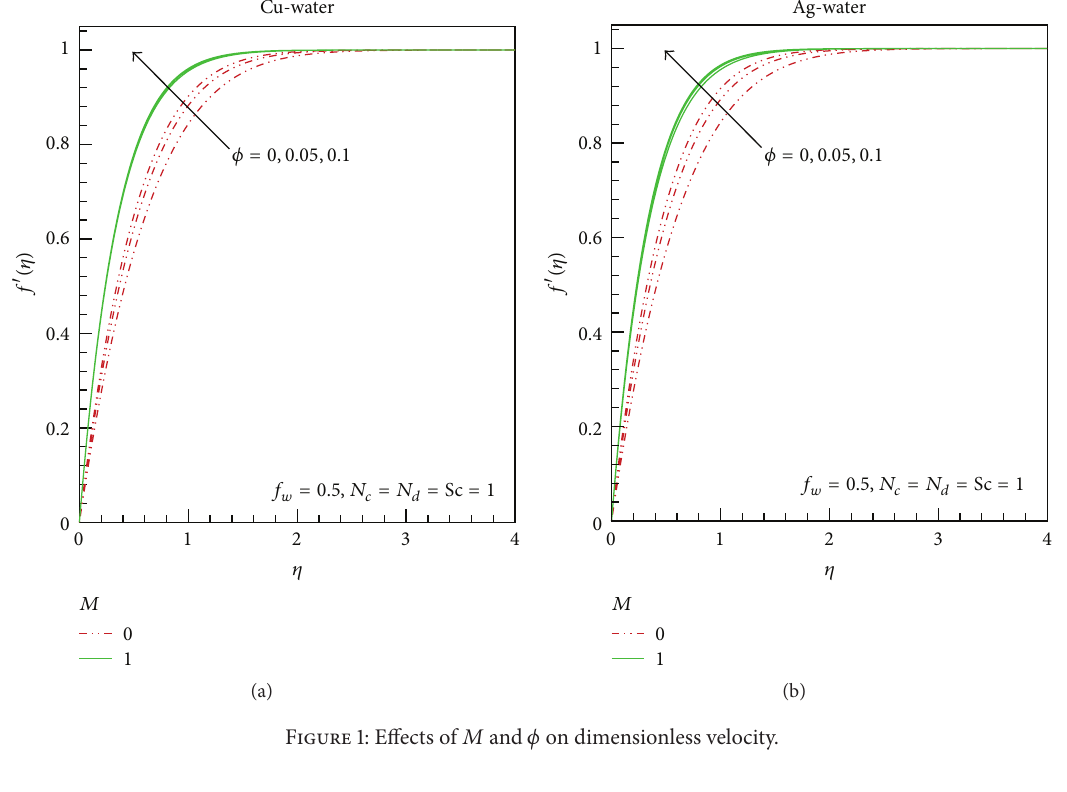
Figure 1: Effects of 𝑀 and 𝜙 on dimensionless velocity.